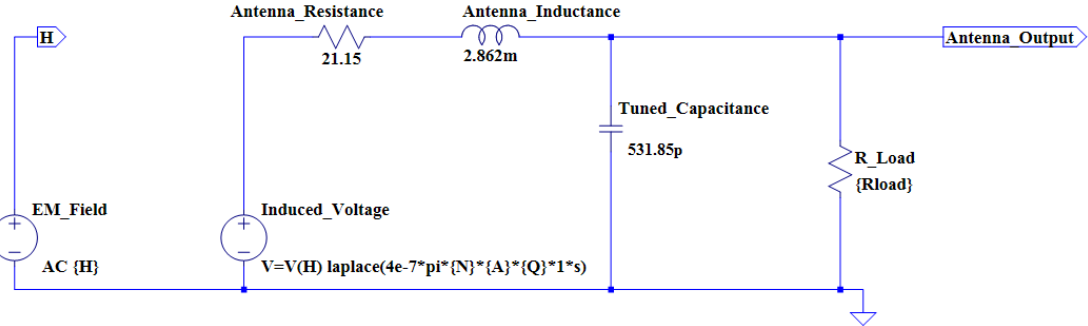
Figure 3. The circular antenna simulation model. Table 5. The design parameters of the square coil antenna.